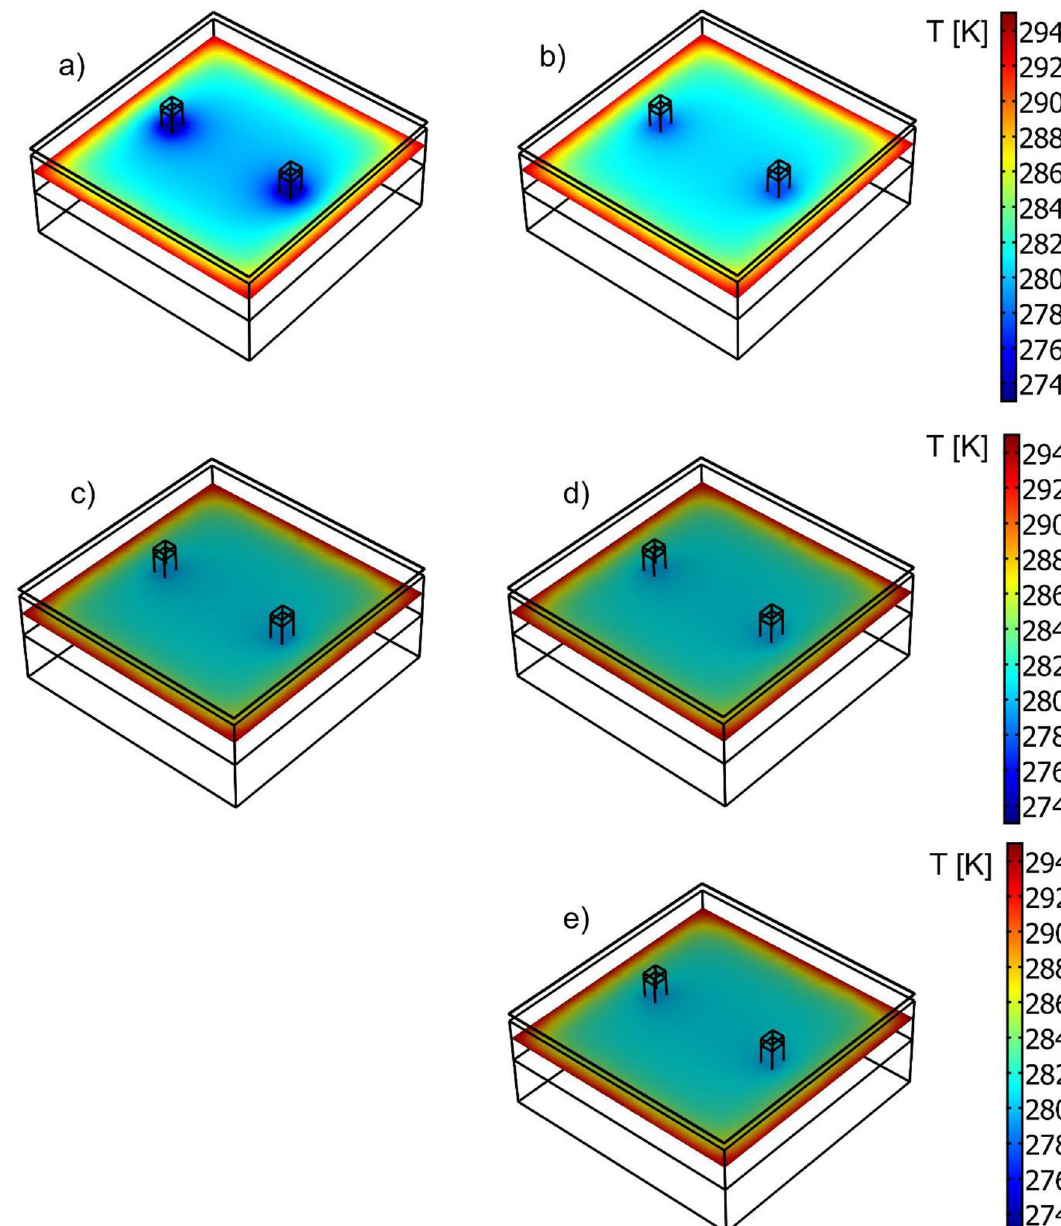
Figure 11. Computed temperature field in transverse cross-sections of the multilayer wall with an aluminum cladding. Cases considered: ( a ) aluminum fastener, δf = 4 mm ( b ) aluminum fastener, δ f = 2.75 mm, ( c ) stainless steel fastener δ f = 3 mm, ( d ) stainless steel fastener with holes, δ f = 3 mm, ( e ) stainless steel fastener δ f = 2 Figure 13 illustrates the temperature differences corresponding to the simulation model and the experimental thermograms. The temperature difference area studied was limited by two circles of diameters d 1 and d 2 . The diameter d 1 , equal to 78 mm, corresponds approximately to that of the circle circumscribed around the fastener’s cross-section. Diameter d 2 was twice the diameter d 1 for simulation and validation. The numerical results were validated by comparing the obtained values T simul with temperature measurements Tmeasured in the corresponding conditions. A numerical model is considered well-validated if the relative dif- ference between the results above is less than 10% 23 . The relative difference was calculated as follows: